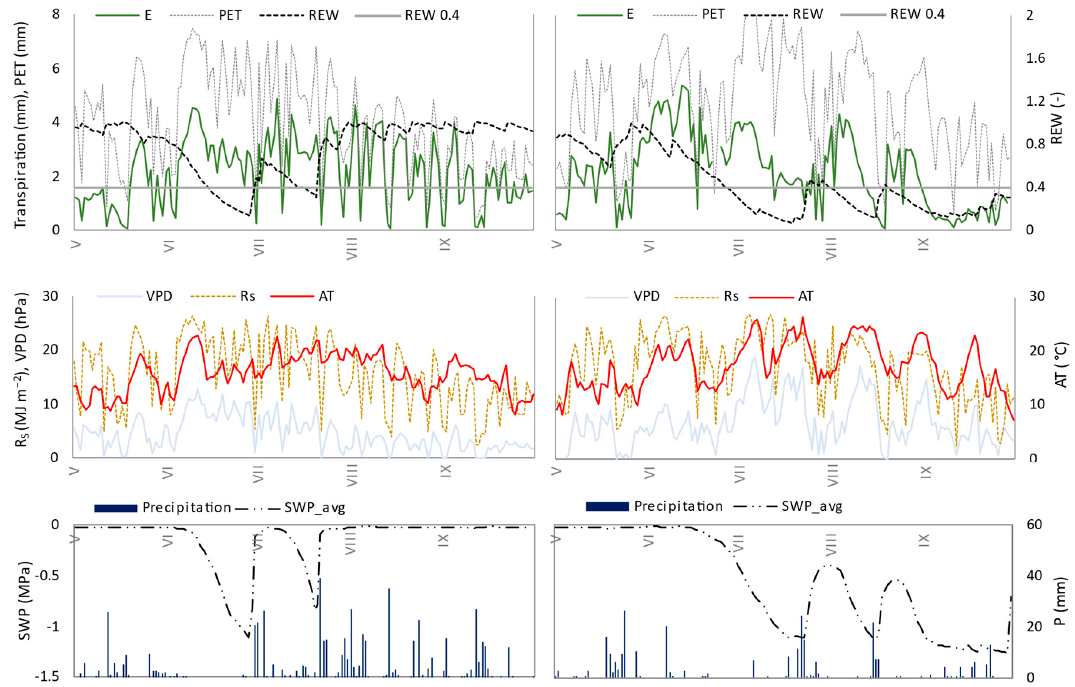
Figure 6. Seasonal dynamics of transpiration and potential evapotranspiration ( PET ) during vegetation season of 2014 ( left ) and 2015 ( right ) and the course of relative extractable water ( REW ) with a marked threshold of 0.4 ( top ); daily values of global radiation ( R S ) vapour pressure deficit ( VPD ) and average air temperature ( AT ) ( middle ); daily values of average soil water potential and precipitation totals ( P) ( bottom ).